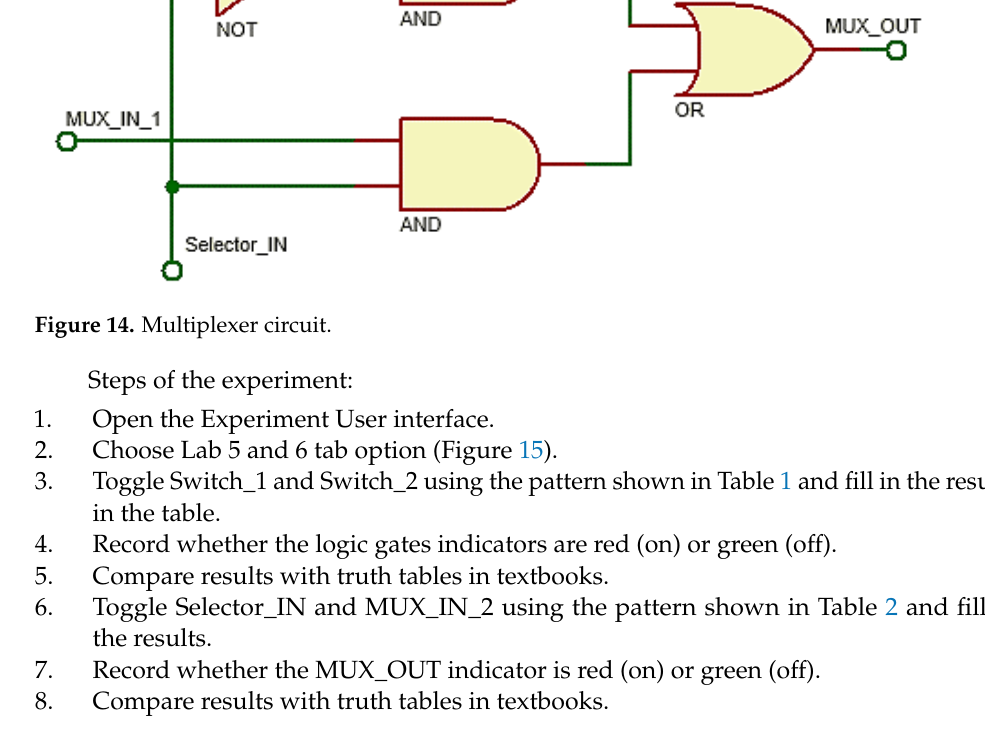
Figure 14. Multiplexer circuit.